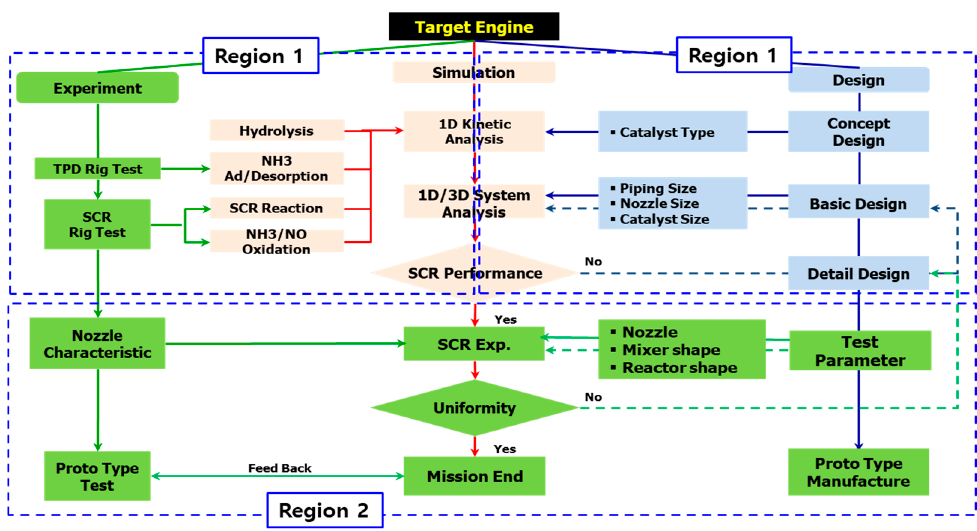
Figure 2. Schematic of SCR system development process.